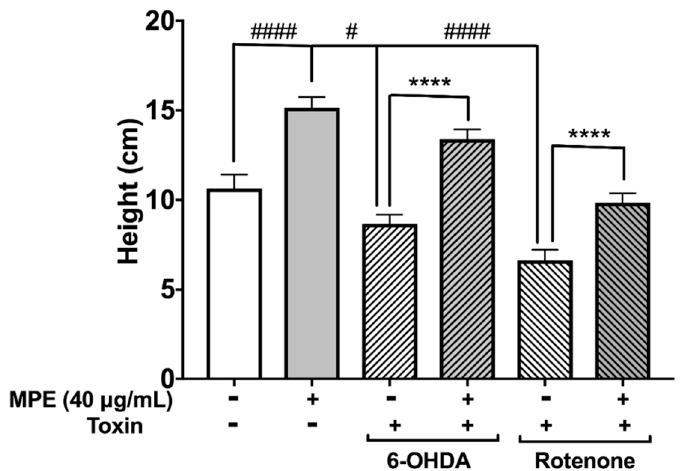
Figure 5. Effects of MPE on negative geotaxis in Drosophila melanogaster . Effects of MPE (40 μ g/mL) alone on climbing ability, by MPE after 6-OHDA (1 mM) exposure, and on MPE climbing ability after rotenone exposure (500 μ M). Significance was determined as compared with control and p ≤ 0.05 (#) and p ≤ 0.0001 (####); compared with toxic treatment using Welch’s t-test with three replicates of n > 40, p ≤ 0.0001 (****).